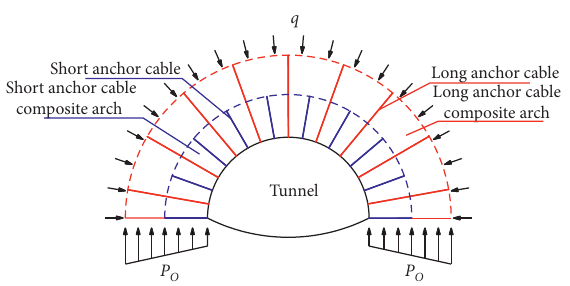
Figure 16: Bearing structure of double-layer composite